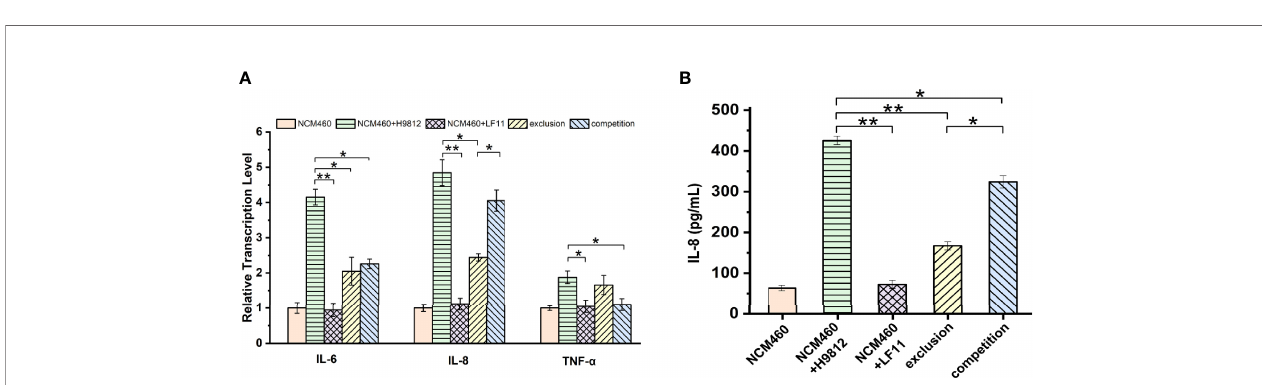
FIGURE 5 | B. subtilis LF11 attenuates the expression of the proin fl ammatory cytokines. (A) Relative gene transcription levels of three proin fl ammatory cytokines in NCM460 cells in various treatments. The b -actin was used as the housekeeping gene, the data of relative gene transcription and expression levels were analyzed using the 2 - DD Ct method, and the gene transcription levels of three proin fl ammatory cytokines in control NCM460 cells are de fi ned as 1.0. (B) IL-8 production in NCM460 cells induced by various treatments with B. subtilis LF11, S. braenderup H9812 and their combinations. Error bars represented standard errors from three replicate experiments. * p < 0.05, ** p < 0.01.